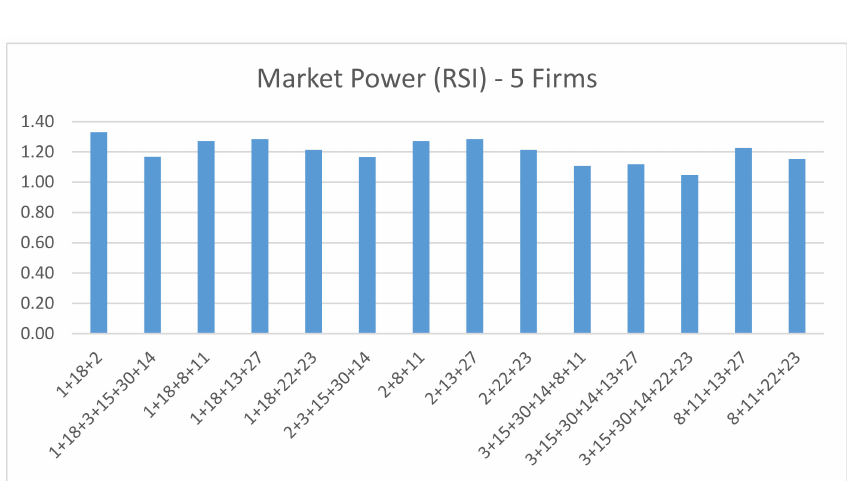
Figure 20. RSI for 6 firms’ setting (Cournot).